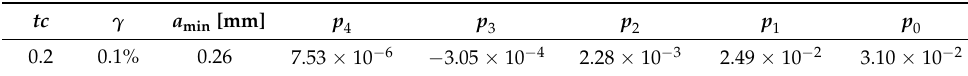
Figure 6. Database values from [21] results: ( a ) Crack growth fourth-degree polynomial considering contact stress and wear ( tc = 0.2 and γ = 0.1%); ( b ) Minimum crack length for different creepages and traction coefficients. Table 1. Example of crack growth database.